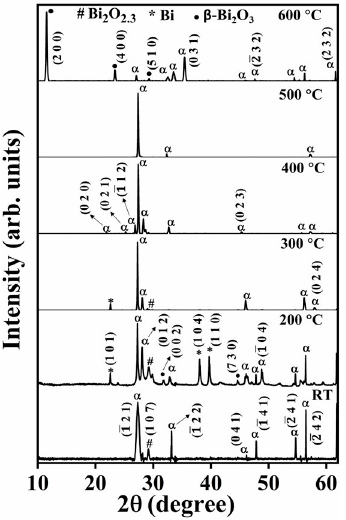
Figure 1. XRD patterns of as ‐ deposited Bi 2 O 3 :Ho 3+ thin films deposited at the different substrate Figure1. XRDpatternsofas-depositedBi 2 O 3 :Ho 3 + temperatures.